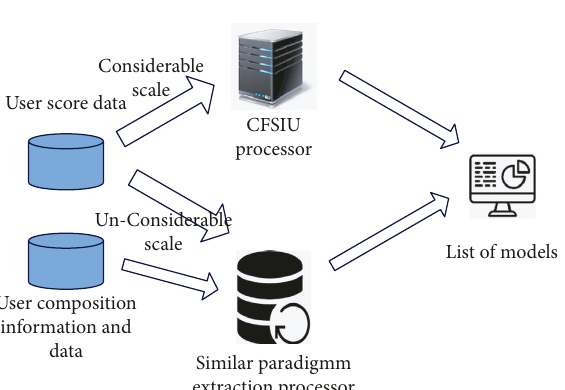
Figure 5: System work flow chart.